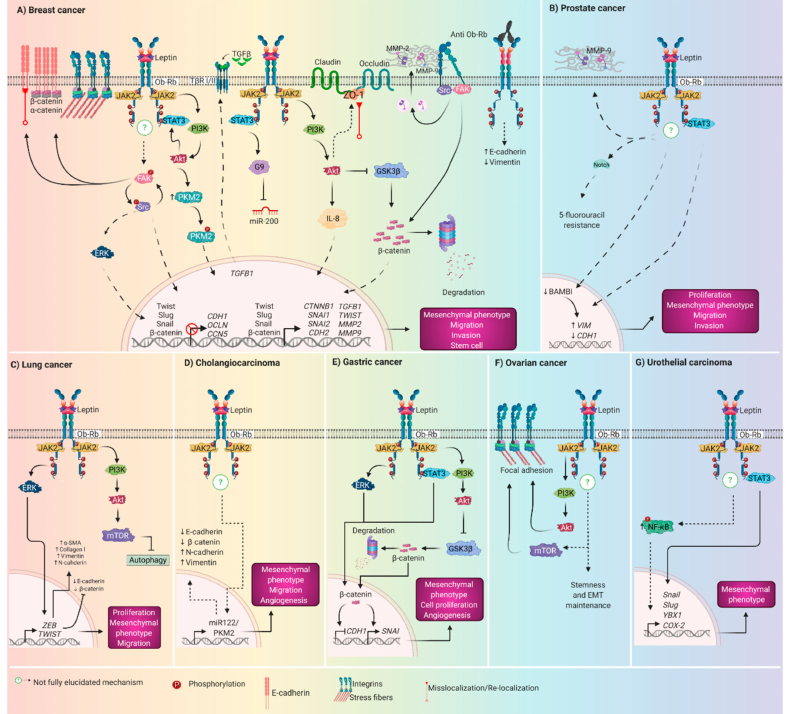
Figure 3. Leptin-induced signaling pathways driving EMT in cancer. Across several signaling pathways, leptin acts as an inducer of EMT in di ff erent types of human cancer: ( A ) Breast cancer; ( B ) prostate cancer; ( C ) lung cancer; ( D ) cholangiocarcinoma ( E ) gastric cancer ( F ) ovarian cancer, and ( G ) urothelial carcinoma. Once leptin binds to ObR-b, signaling pathways are activated synergically mechanisms(discontinuousarrows)orbyactivatingcanonicalsignalingaxis(continuousarrows)suchas PI3K-Akt, JAK-STAT-Akt, and Wnt / β -catenin ( A ). Interestingly, in addition to the expected